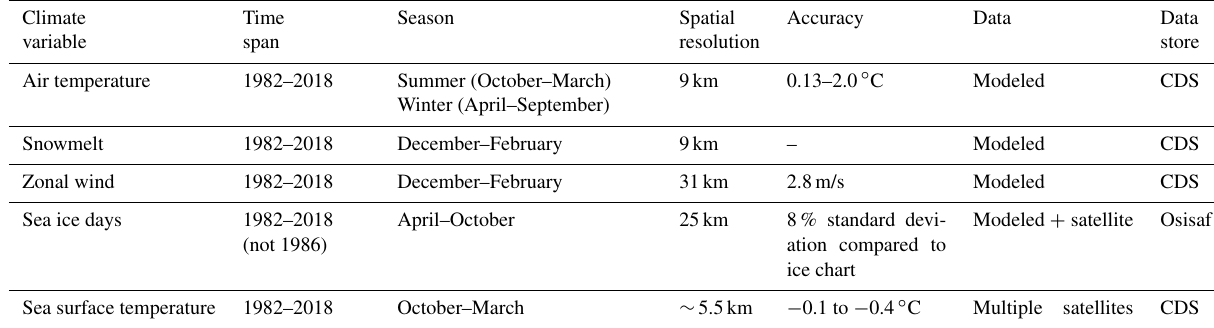
Table 1. Summary of processed climate variable data